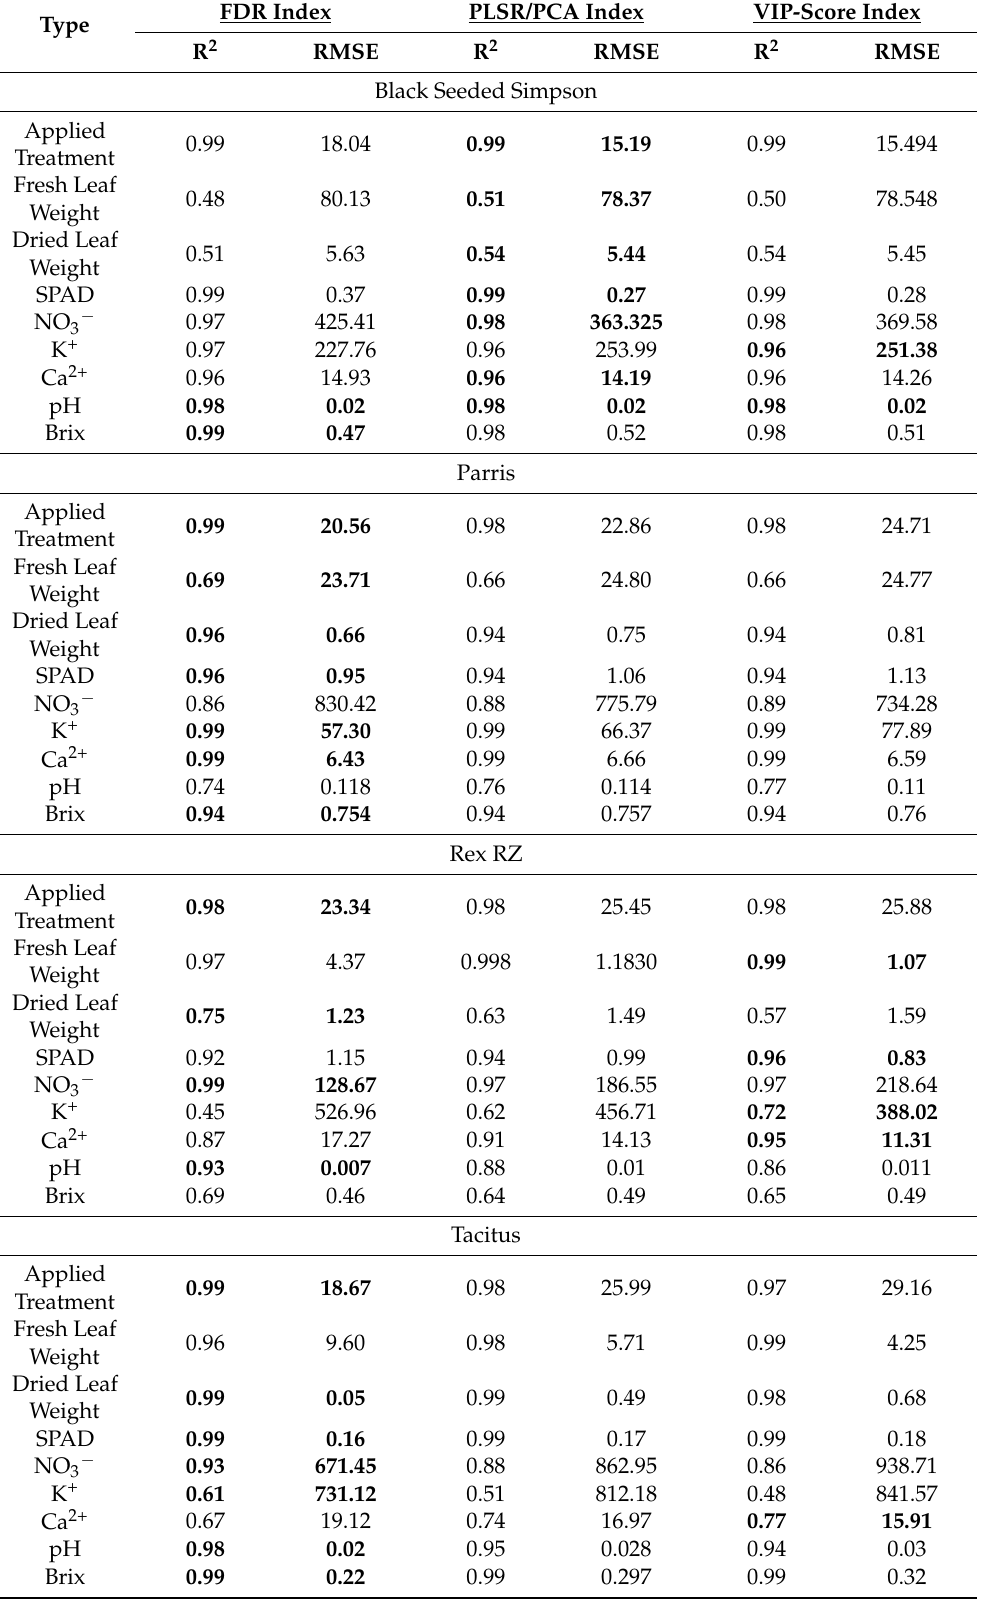
Table 6. Fitted model accuracy (R 2 , RMSE) of models found from RSI, NDSI, PLSR/PCA, and VIP score of PLSR/PCA for NFT-circular-system-grown lettuce